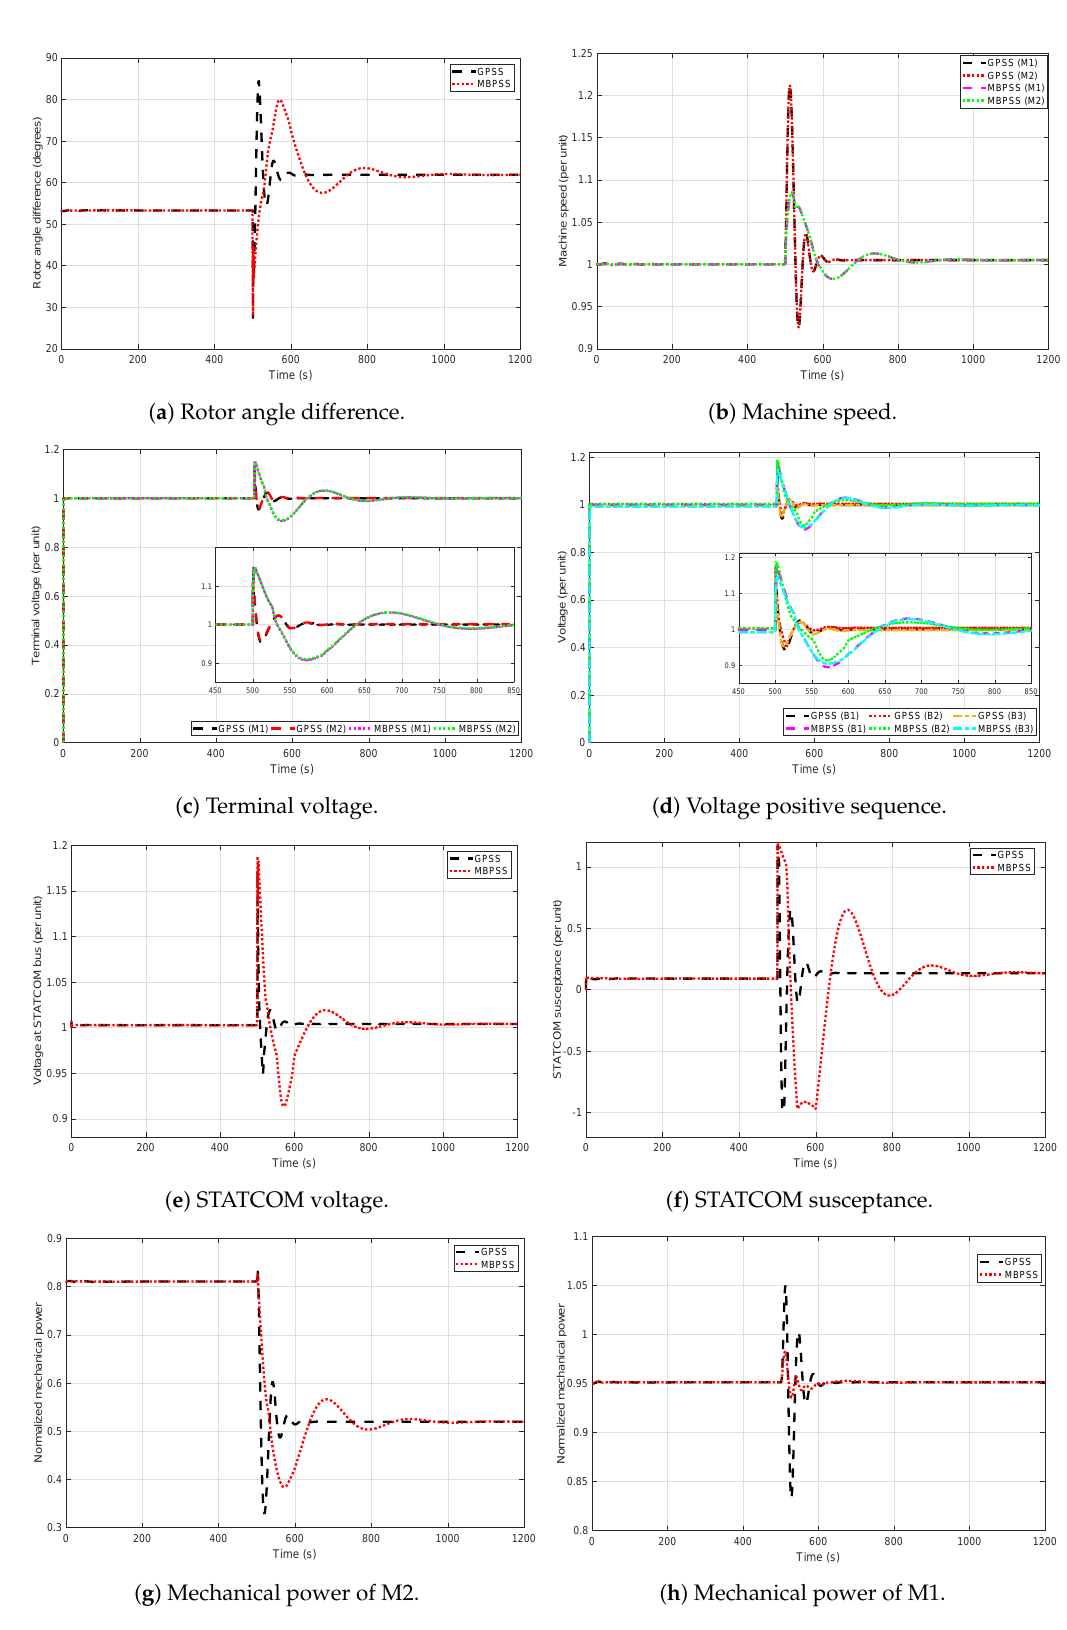
( g ) Mechanical power of M2. ( h ) Mechanical power of M1. Figure 16. Case III.2: Variation in network signals during permanent load loss with generic and multiband PSS with